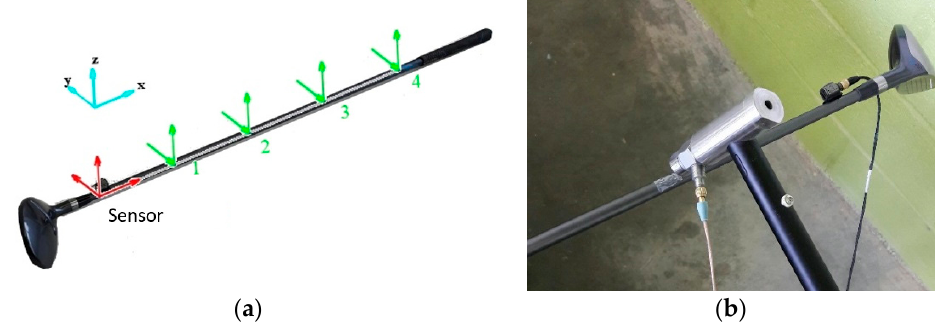
Figure 2. ( a ) Discretized model in OROS Modal. The sensor is a piezoelectric accelerometer, while 1, 2, 3, 4 are the impact locations spaced 12.5 cm apart. ( b ) Example of experimental modal analysis.